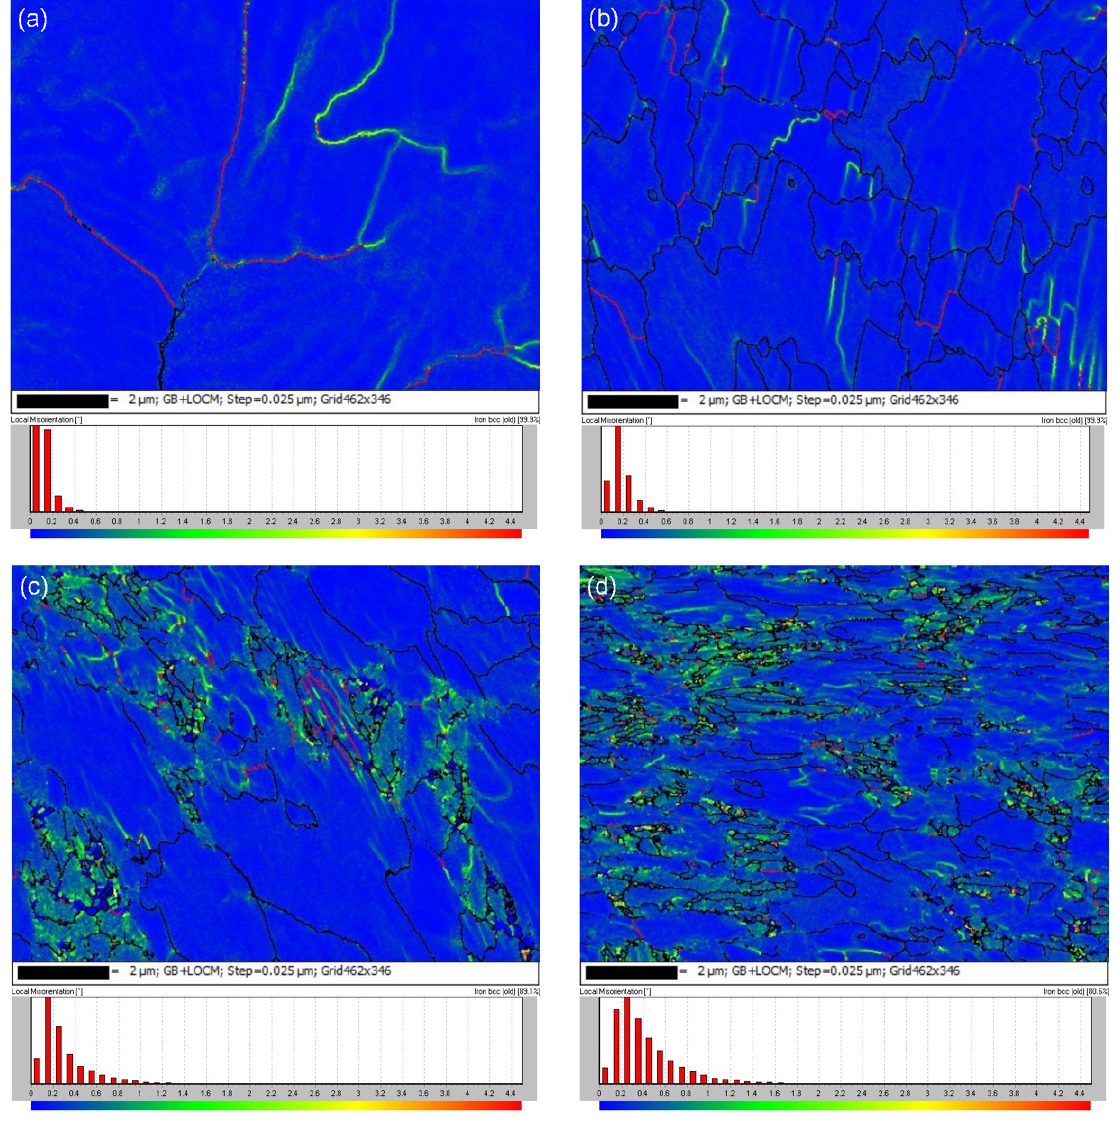
Figure 8. EBSD k ernel average misorientation maps of Group 3. ( a ) BM, ( b ) HAZ, ( c ) TMAZ, ( d ) Figure 8. EBSD kernel average misorientation maps of Group 3. ( a ) BM, ( b ) HAZ, ( c ) TMAZ, CWZ. ( d )